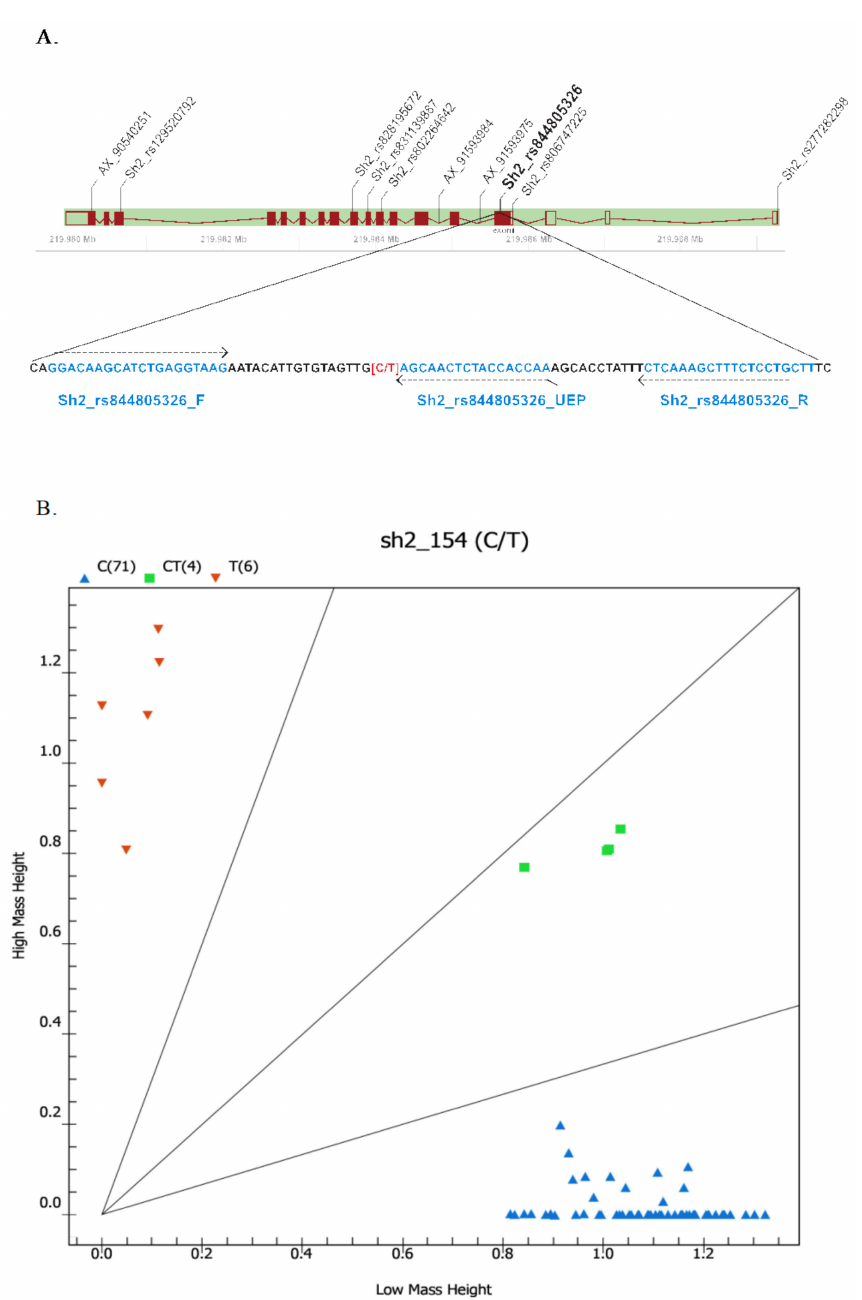
Figure 4. MassArray marker associated with sweetness trait developed based on the SNP in sh2 . ( A ) Physical locations of molecular markers developed on the basis of gene Sh2 . Exons and introns in the gene structure are presented by filled boxes and lines, respectively. Unfilled boxes represent untranslated regions (UTRs). Primers (dashed arrows) are presented along with the target sequence. The letters F and R in the primer’s name indicate forward and reverse primers, respectively. UEP indicated an unextended primer used in a single-base primer extension reaction. ( B ) Allelic dis- crimination plot of marker Sh2_rs844805326 (SNP 154_CT) validated in panel of 81 lines consisting of different types of corn analyzed by MassARRAY ® platform. Scatter dots with different colors show clustering of homozygous genotype TT (brown), heterozygous genotype CT (green), and homozygous genotype CC